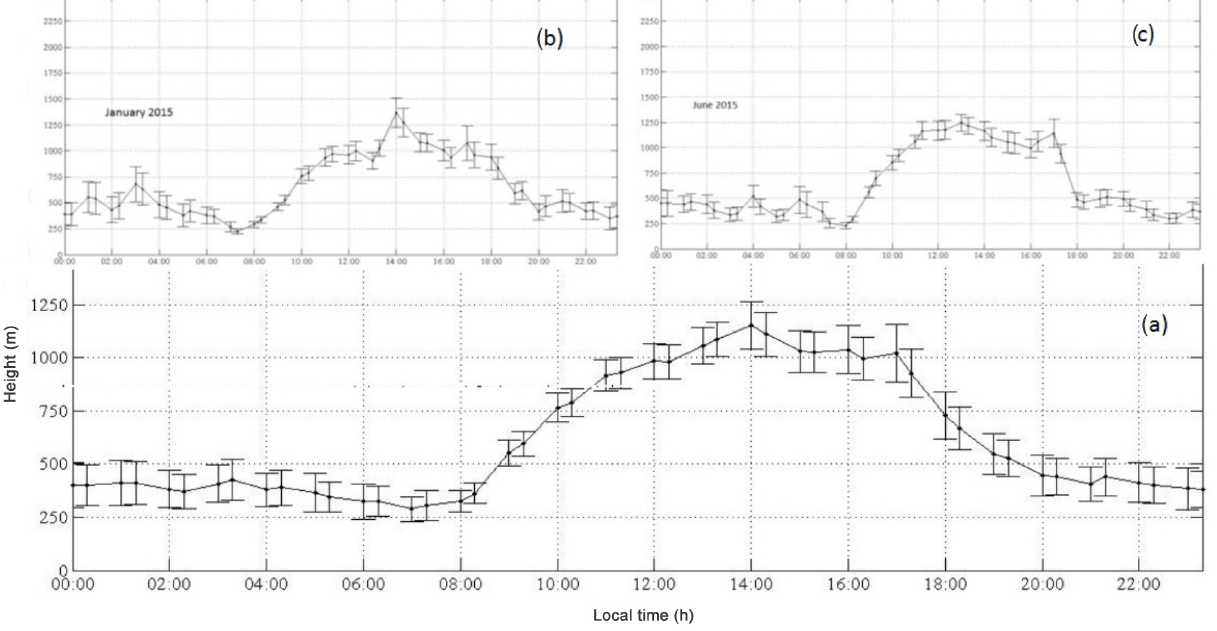
Figure 8. Diurnal cycle of the height of boundary (m) layer (average from 1 January up to 30 June 2015) (a) , from January 2015 (b) and June 2015 (c)